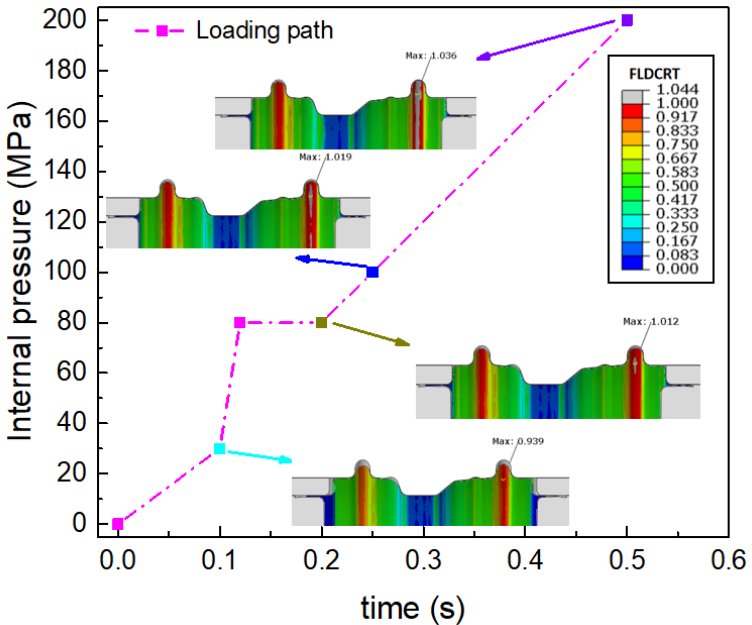
Figure 9. The forming limit results with the conventional hydroforming process. (FLDCRT > 1 means the strain out of material forming limit).